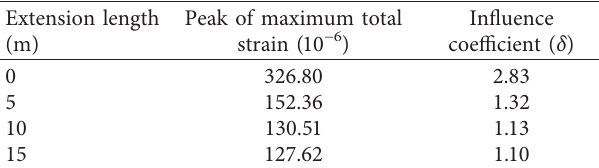
Table 21: Results of different extension